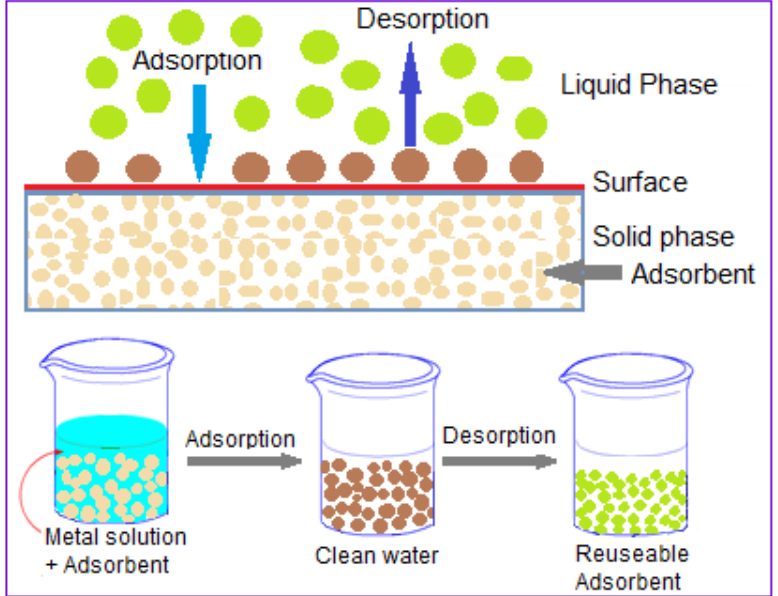
Figure 3. The mechanism of metal ions adsorption–desorption process in water.